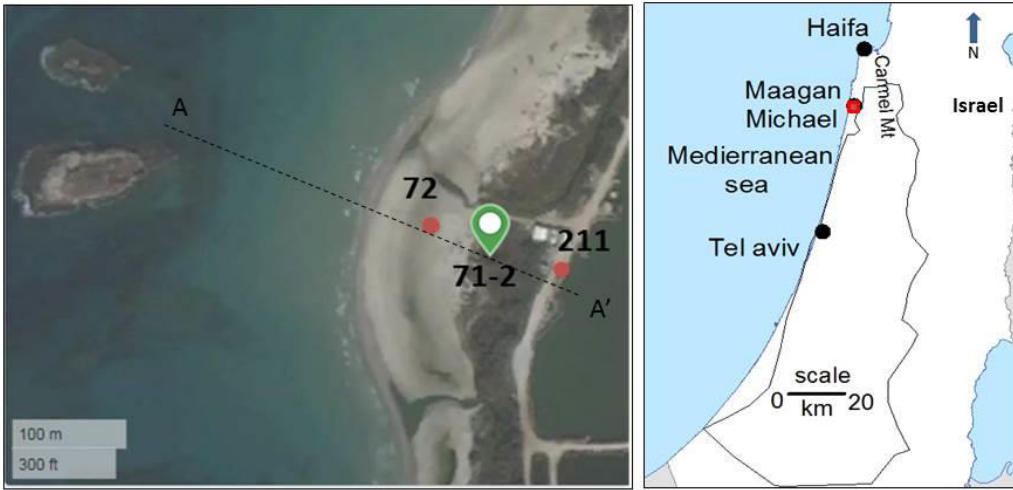
Figure 1. Location map site and a map of well location. Well 211 is a pumping well, while wells 72 and 71-2 are observation wells. The grey line on the right figure denotes the boundary of the basin of the Late Cretaceous Yarkon Taninim aquifer. Shown also is the location of geological cross section of Figure 2.